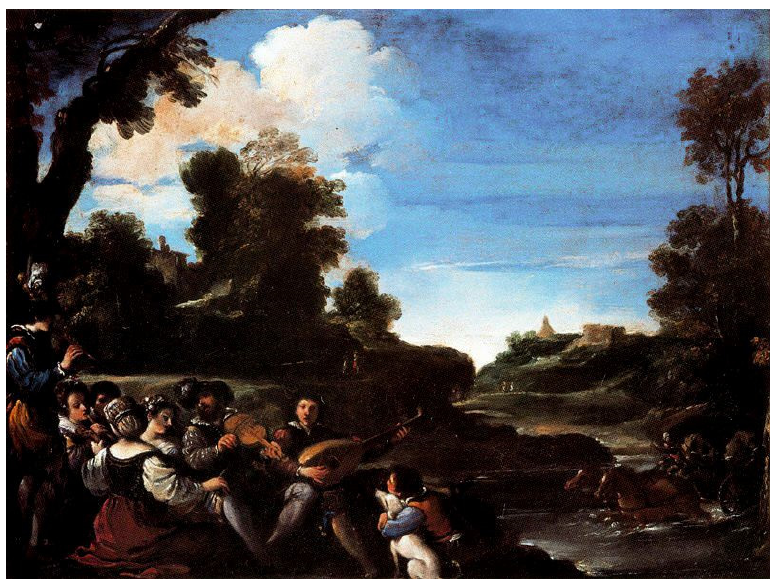
Figure 10. Guercino, Landscape with a Concert , 1617, Uffizi, Florence. Photo: Wikimedia Commons, Public Domain.